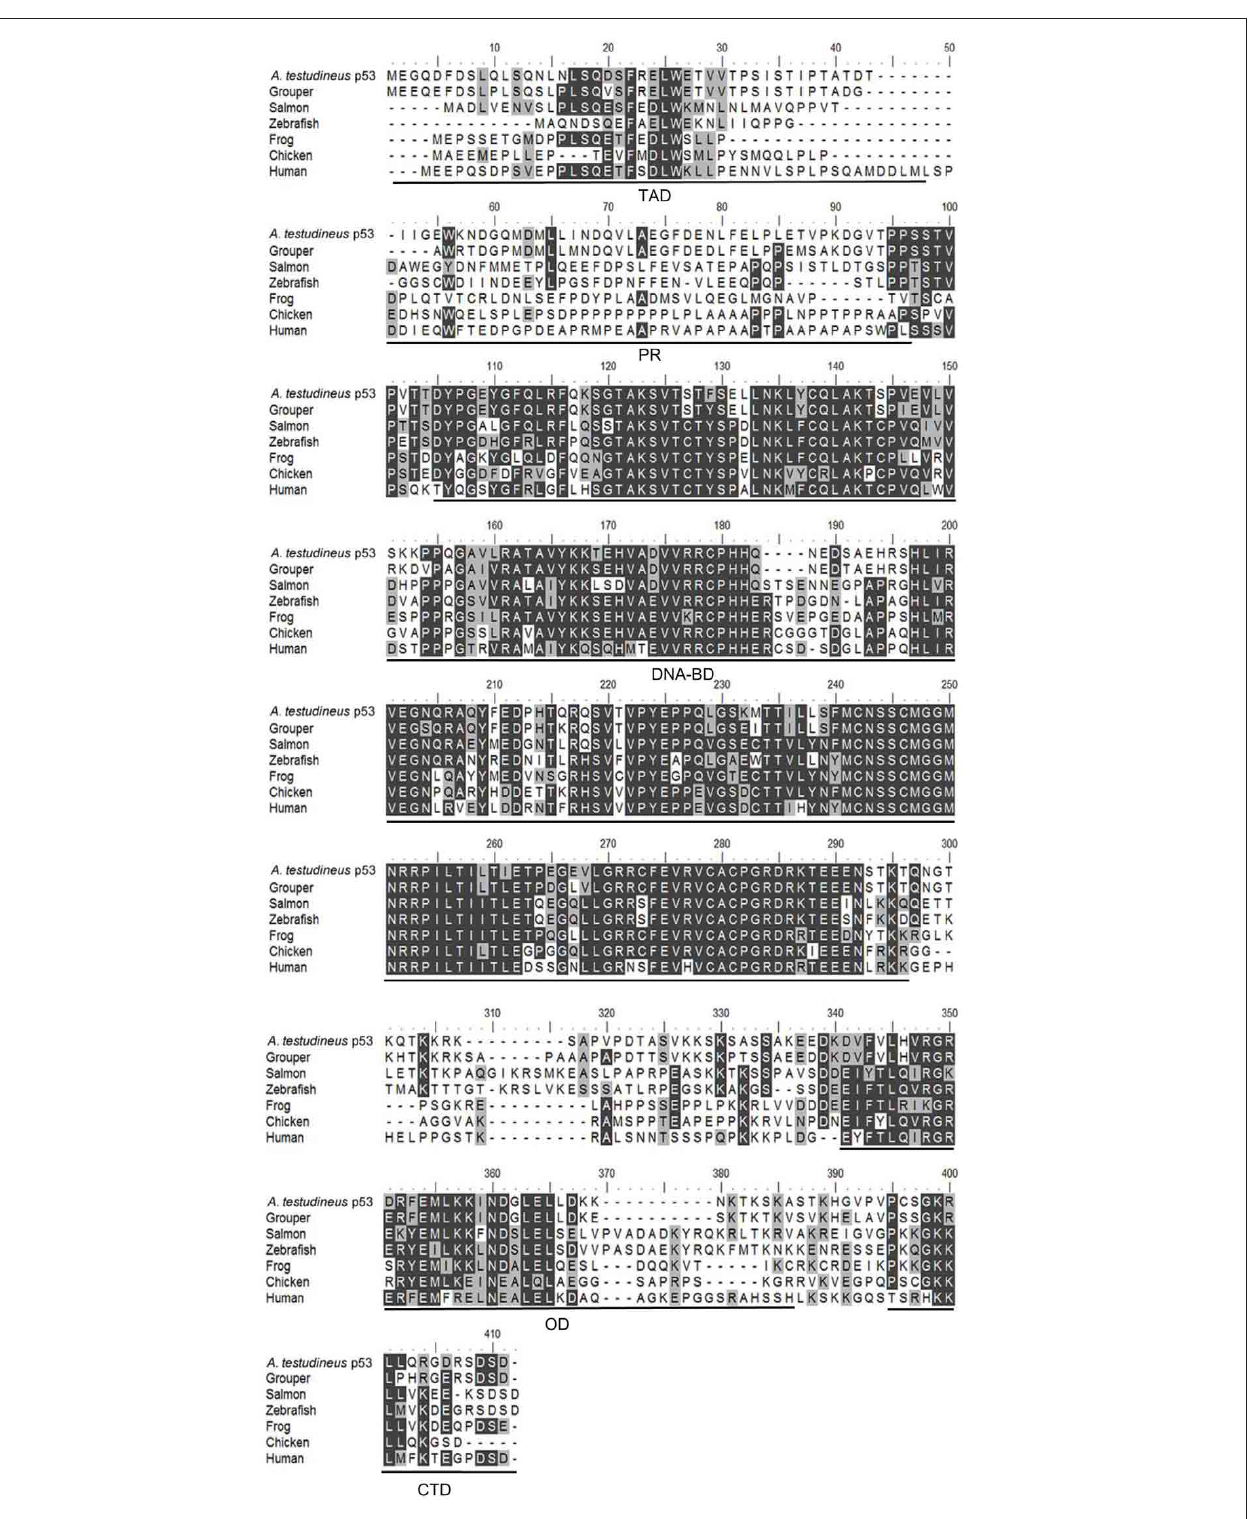
Ictalurus punctatus (catfish; NP_001187005.1), Danio rerio (zebrafish; NP_571402.1), Xenopus laevis (frog; CAA54672.1), Gallus gallus (chicken; NP_990595.1), Mus musculus (mouse; BAA82344.1), and Homo sapiens (human; BAC16799.1). Identical amino acids are indicated